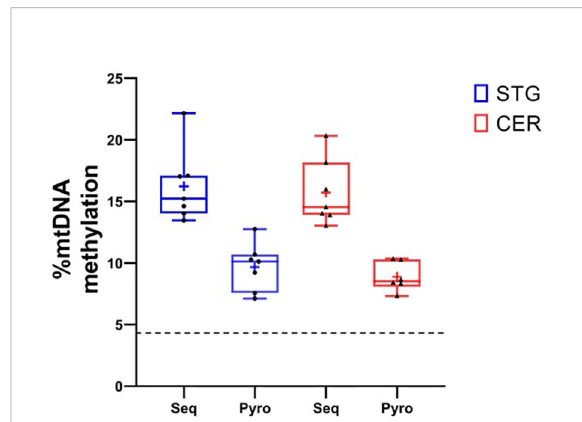
FIGURE 2 Validation of mtDNA methylation in the D-Loop using pyrosequencing. Box plots showing % methylation levels at site ChrM:545 in the seven donors used in the study, when pro fi led using targeted bisul fi te sequencing (Seq) and pyrosequencing (Pyro) in the STG (blue) and CER (red). Boxplots represent the median (central line) and interquartile range (perimeter), with plus sign denoting the mean, whiskers showing the minimum and maximum value, and individual datapoints shown as black circles (STG) or triangles (CER). The dashed black horizontal line represents the reported minimum threshold for detecting methylation using pyrosequencing